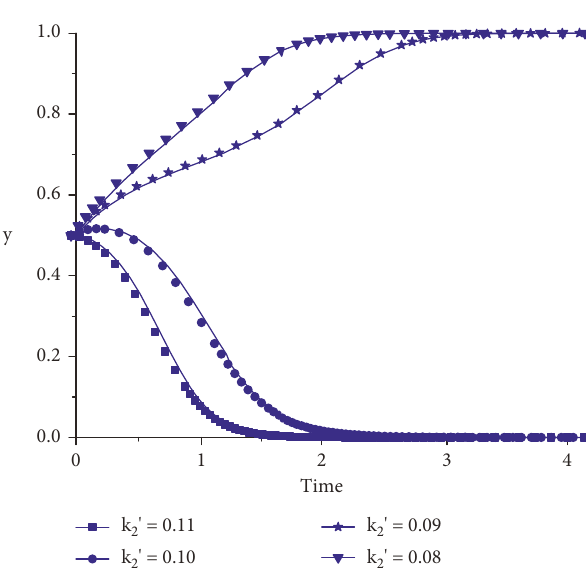
Figure 13: Impact of subjective spill coefficient k